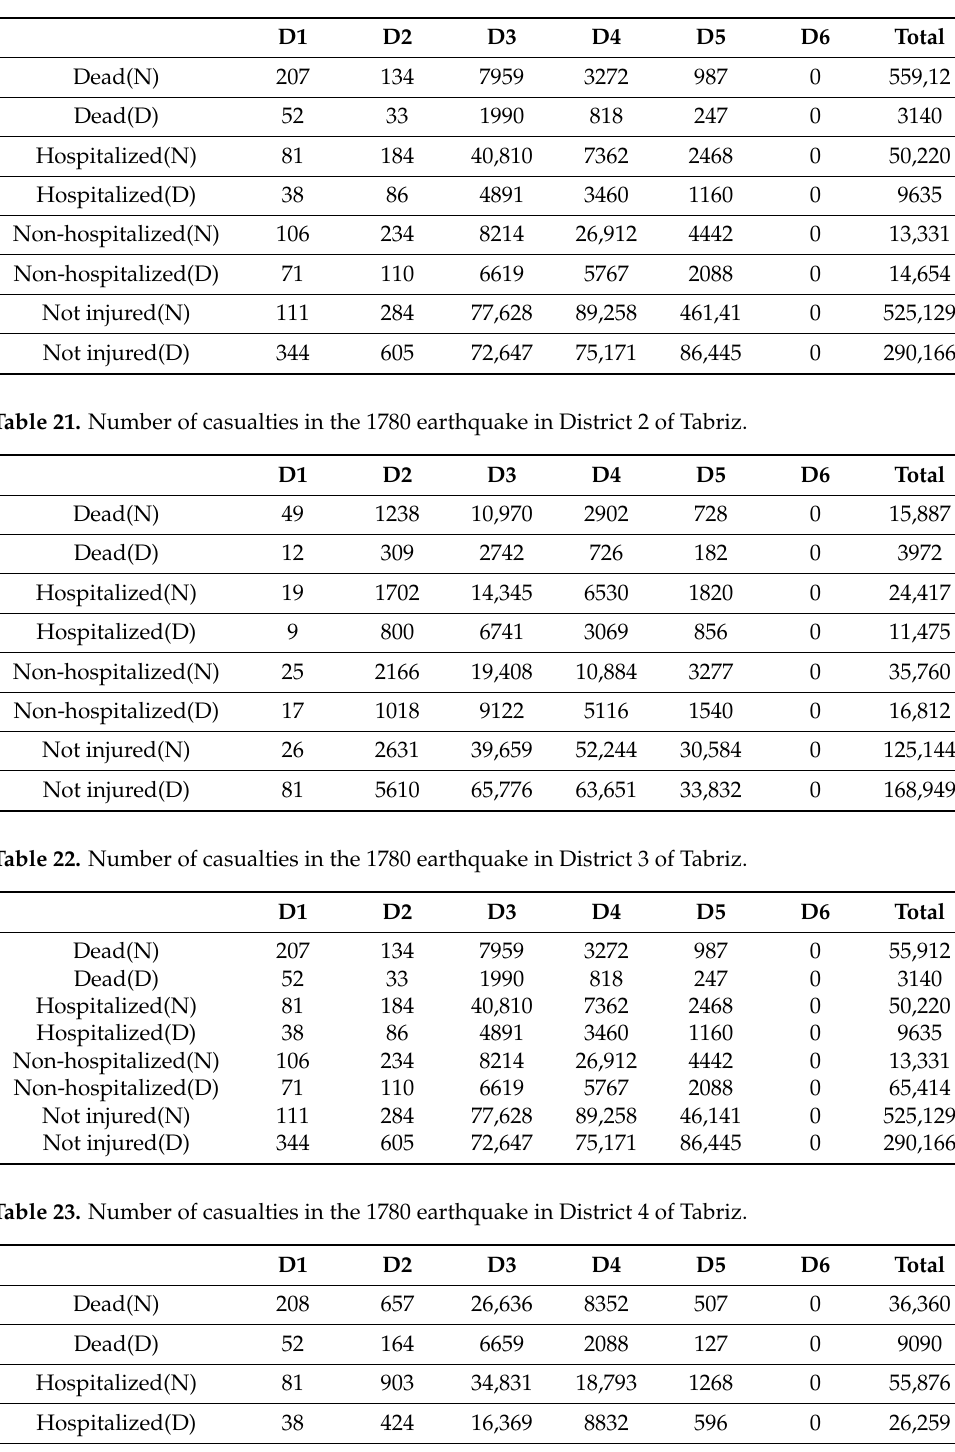
Table 20. Number of casualties in the 1780 earthquake in District 1 of Tabriz.